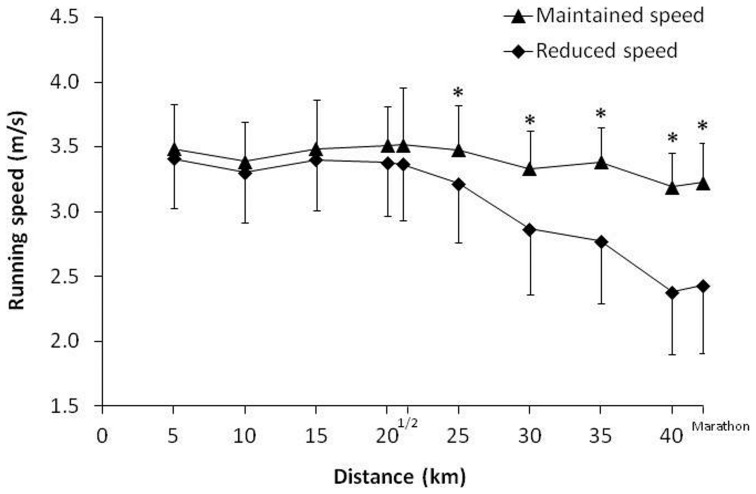
Running pace during a marathon according to the running fatigue experienced from the first 5-km to the end of the race.We have established two groups: runners that preserved their running pace fairly well (N = 22; a running pace decrease of under 15%) and runners with a pronounced decrease in running speed (N = 18; a running pace decrease of over 15%). (*) Different from runners with a pronounced decrease in running pace, at P<0.05.